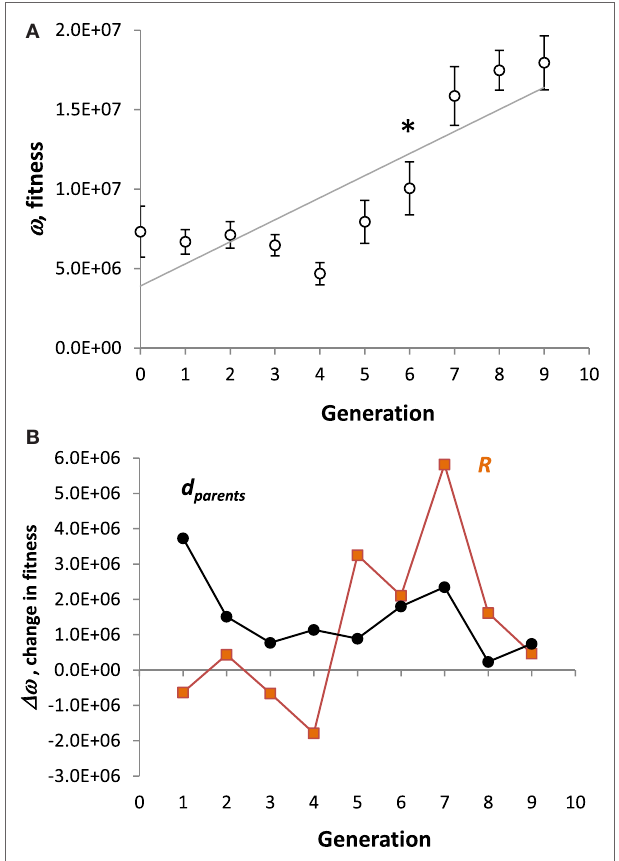
FigUre 6 | evolution of Tadros . (a) Fitness. All values are means ( N = 10) of the population ± SE. A strong directional trend ( p < 0.001, ANOVA) is present, represented by the regression line. In spite of the overall linear trend, the pattern is more complicated: a priori contrasts between generations detect a significant saltation between generations 6 and 7 ( p < 0.05, denoted by *). (B) Change in fitness. The selection differential, d parents , is the difference in the mean fitness between parents selected to reproduce and the mean fitness of the parental population. The evolutionary response, R , is the difference between the mean fitness of the offspring and the mean fitness of the